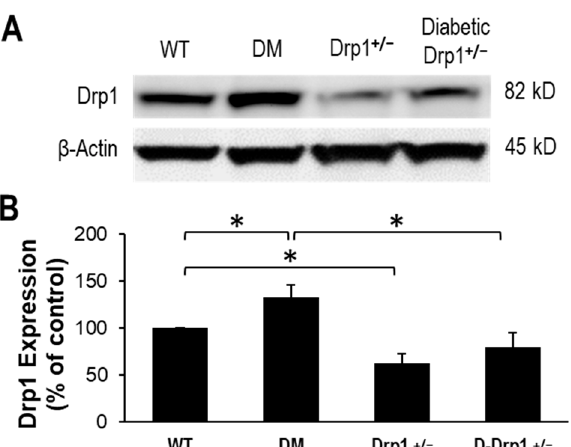
Figure 3. Drp1 expression is normalized in diabetic Drp1 +/ − mouse retinas. ( A ) Representative WB image shows Drp1 protein levels in the retinas of WT, diabetic (DM), Drp1 +/ − , and diabetic Drp1 +/ − (D-Drp1 +/ − ) mice. ( B ) Graphical illustration of cumulative data shows diabetes significantly upregulates Drp1 expression and that Drp1 expression is normalized in retinas of D-Drp1 +/ − mice. Data are expressed as mean ± SD. * p < 0.01, n = 12.